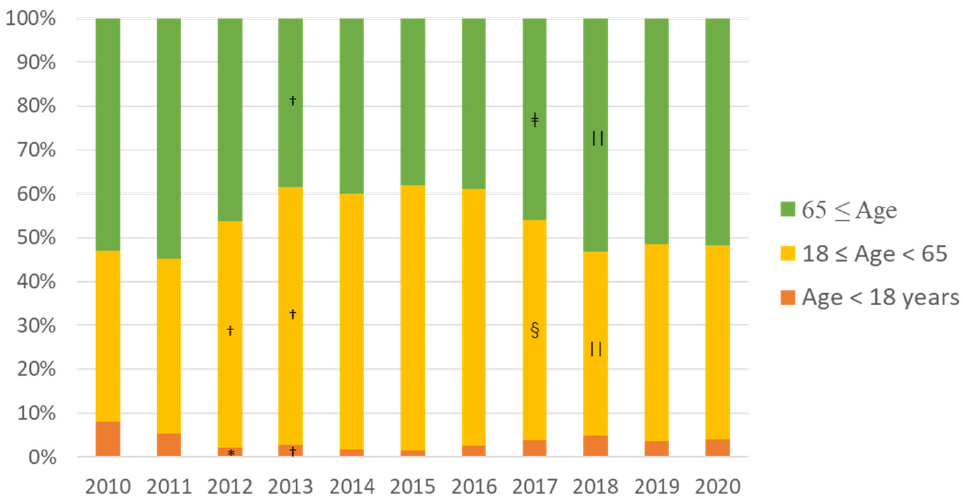
Figure 4. Proportion in each age cohort transported by ambulance before and after the Fukushima accident (2011). * p = 0.001, † p < 0.001 vs. 2010; ‡ p = 0.011, § p = 0.003, || p < 0.001 vs. 2016. The number of young (<18 years old) and older people ( ≥ 65) decreased after the accident compared with before the earthquake (* and †), but, after 2017, when the return of the residents of Namie and Tomioka Town began, the proportion of older people increased compared with 2016 (‡, ||).